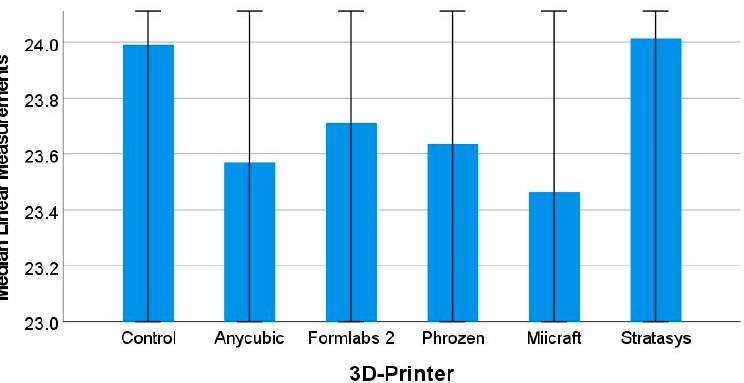
Figure 3. Median linear variations (in millimeters) and standard error of control (digital measure- ments performed on the CAD software), and digital caliper measurements on 3D-printed dental casts. Note that the Stratasys 3D printer (Polyjet) presented the closest values to the control digital ones. Measurements are shown in millimeters. Error bars are limited to the amplitude of the scale used to depict the differences found and showed similar results for all 3D printers.